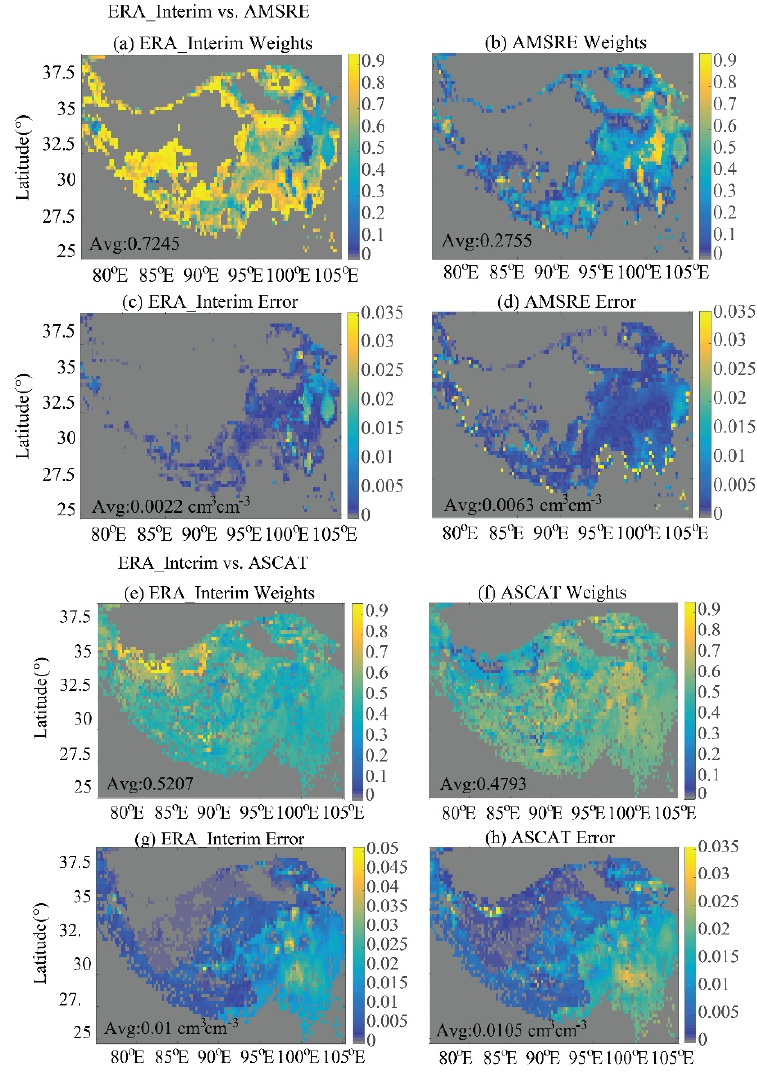
Figure 8. Weights and relative errors for those scaled AMSRE and ASCAT data, not collocating with each other, but with the scaled ERA-Interim data: ( a – d ) ERA-Interim vs. AMSRE; ( e – h ) ERA-Interim vs. ASCAT.